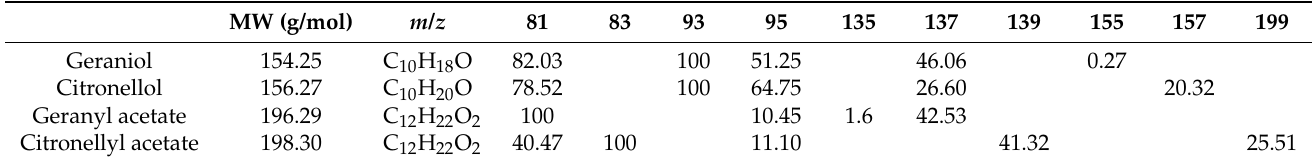
Table 3. Terpenes, their molecular weight (MW), and formular and relative abundances of their different fragments determined by